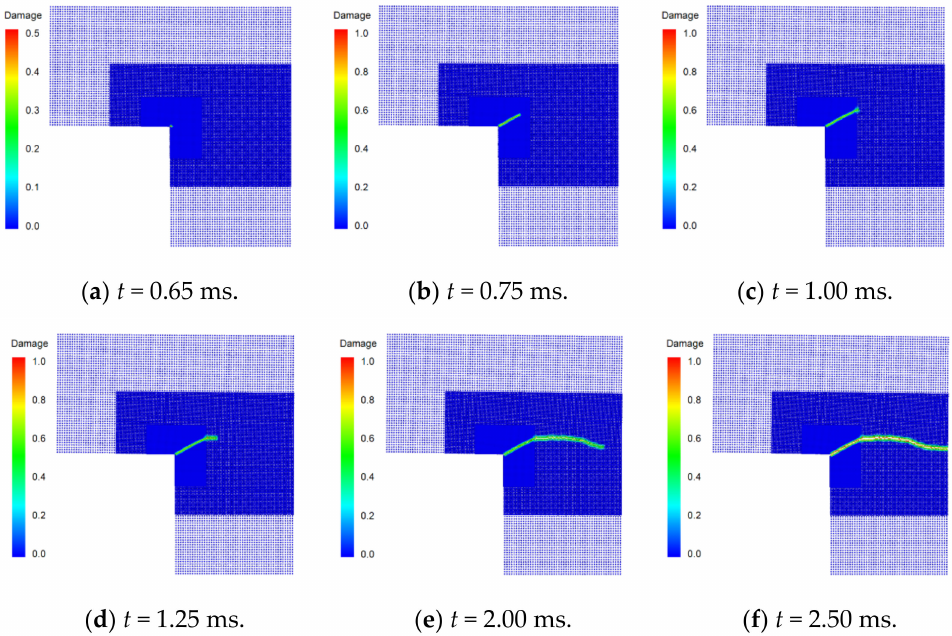
Figure 15. Snapshots of simulated crack propagation in the L-shaped plate.